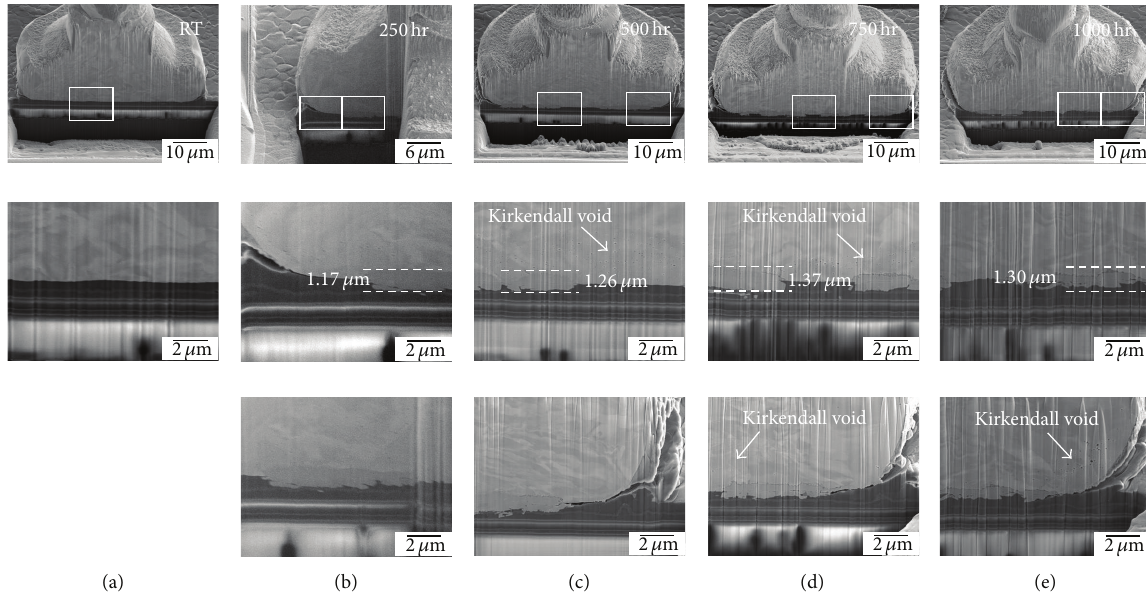
Figure 4: Observations of bonding interface cross-section featured the following conditions: (a) as-bonded interface at room temperature. Intermetallic compounds were grown for (b) 250 hr, (c) 500 hr, (d) 750 hr, and (e) 1000 hr.